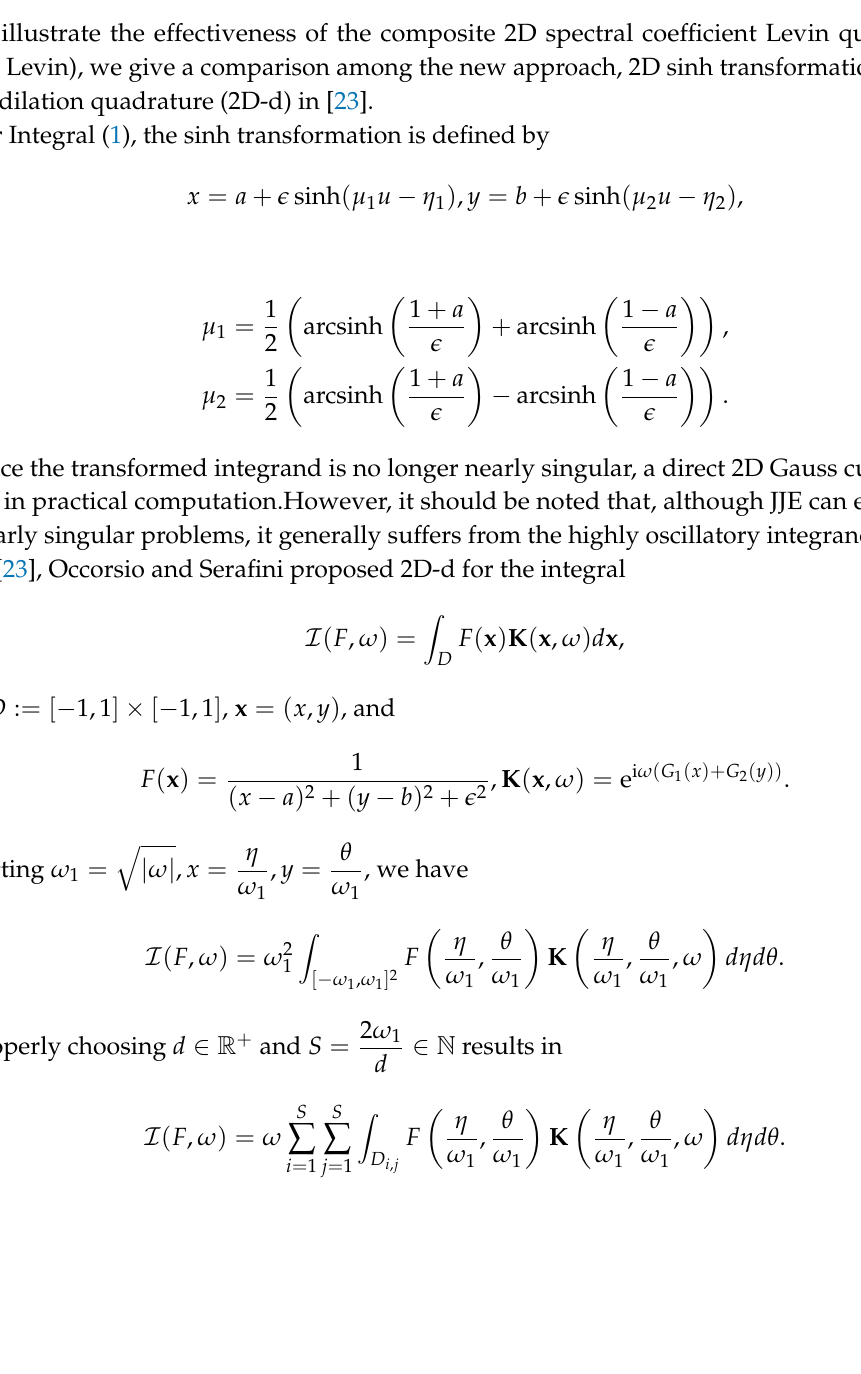
Figure 6. Comparison between 2DSC-Levin and 2D-Cheb in Example 2, ω is a variable (left: absolute errors, right: CPU